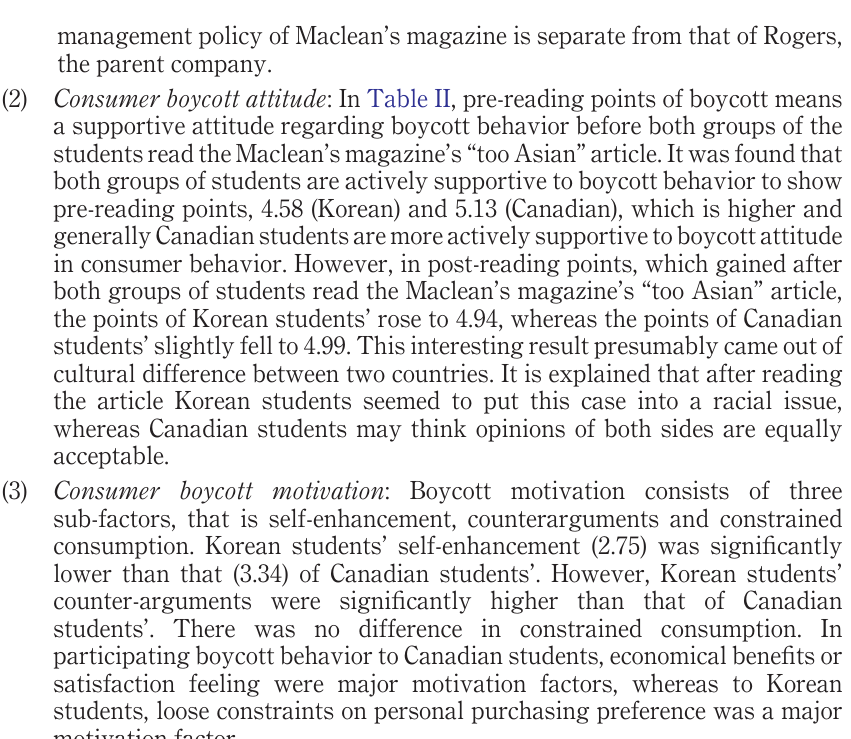
Table II. Results of the t -test among variables